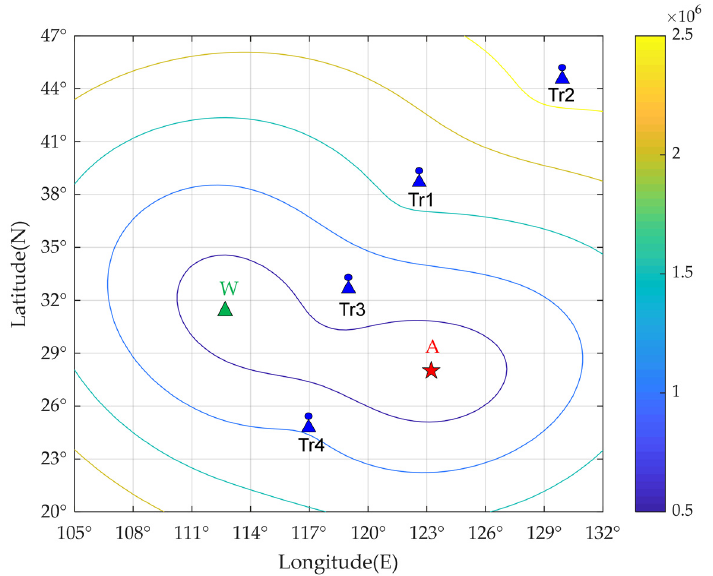
Figure 4. Contour map of 𝐹(cid:4666)𝜑 , 𝜆(cid:4667) when the transmitting stations are linearly distributed.